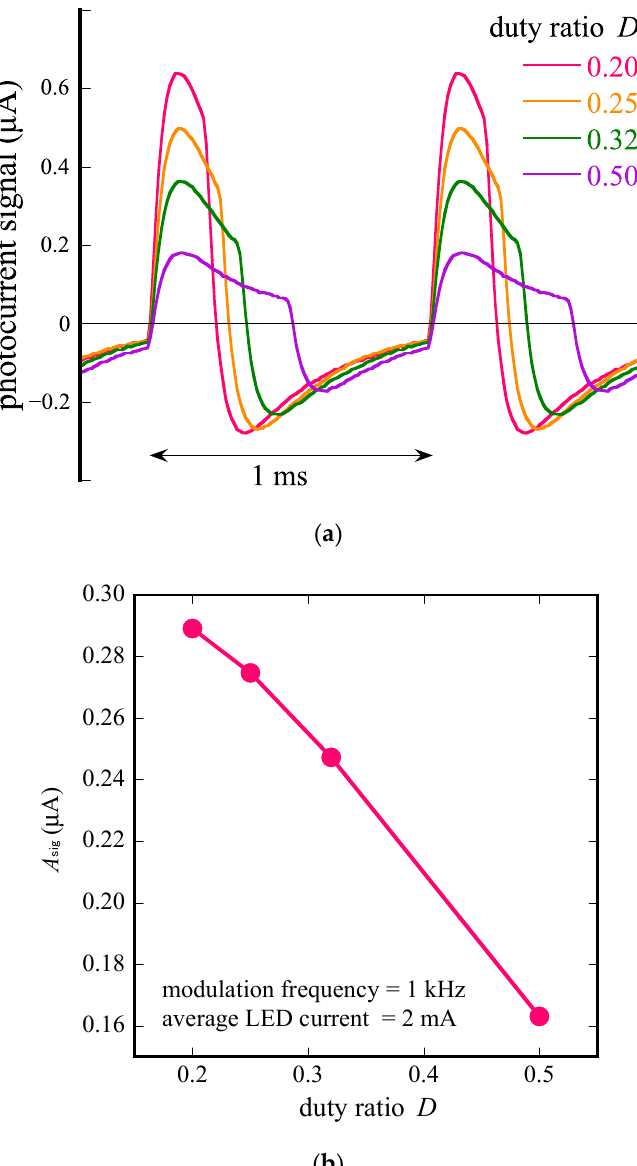
Figure 4. ( a ) Waveforms of I sig ( t ) for different duty ratios (0.20, 0.25, 0.32, and 0.50) of square waves of I L ( t ) with the same frequency (1 kHz) and the same average LED current (2 mA). All waveforms shown were averaged over 100 cycles. ( b ) Amplitude of fundamental frequency of photocurrent signal ( 𝐴 sig ), plotted as a function of duty ratio ( 𝐷 ).